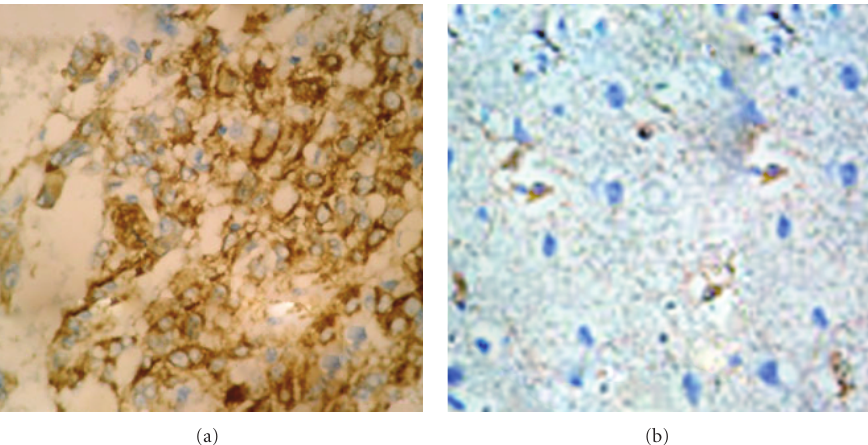
Figure 1: Immunohistochemical staining of CD24 protein in tumor cells of high-grade glioma (a) and nonneoplastic brain (b) tissues (original magnification × 400). Staining for this antigen is described in Section 2. Positive staining of CD24 is seen in the cytoplasm and membrane of tumor cells in gliomas, whereas the nonneoplastic brain tissues showed no expression of CD24.